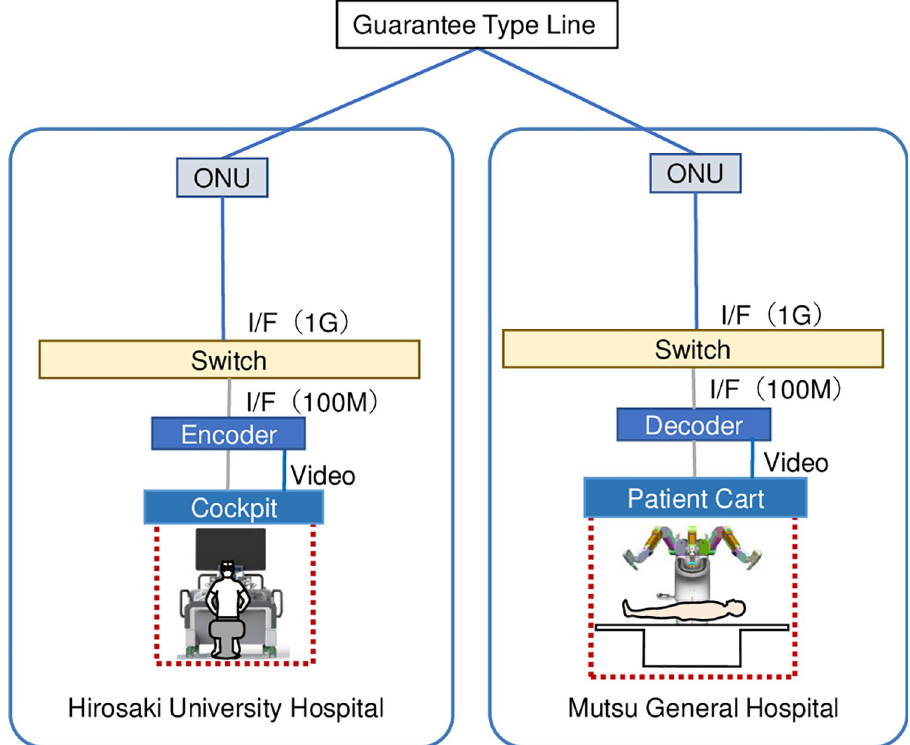
Fig 1. Network system. Hirosaki University Hospital and Mutsu General Hospital, located about 150 km apart, were connected through a commercial bandwidth-guaranteed line. OUN: Optic network unit, CPE RT: Customer premises equipment remote terminal, I/F: